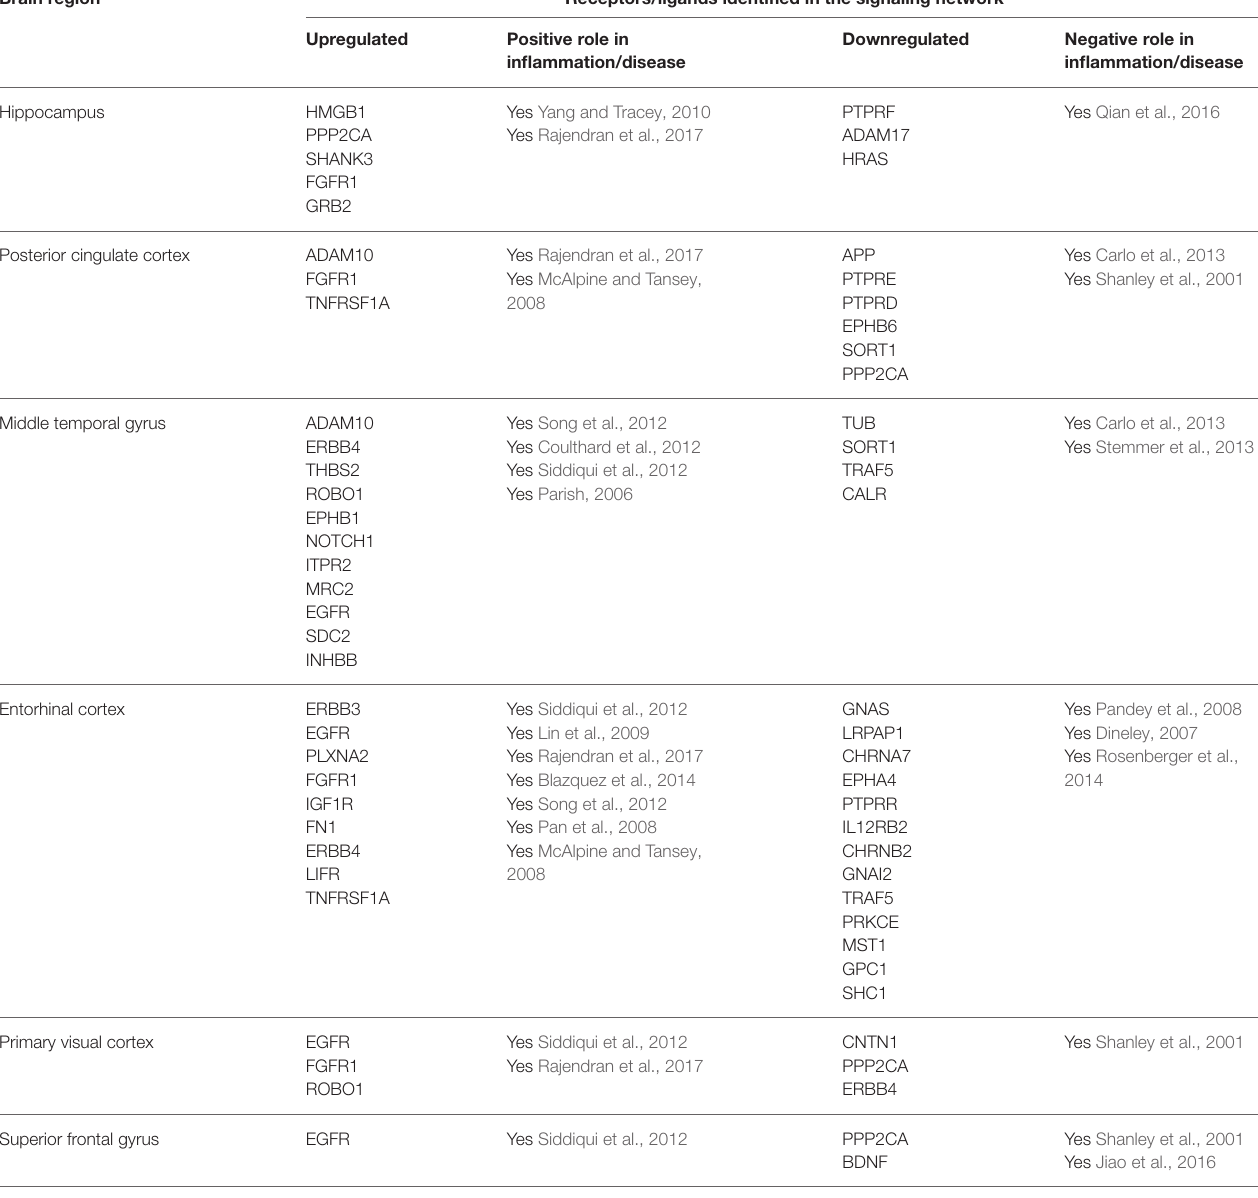
TABLE 1 | Identification of AD specific factors. Brain region Receptors/ligands identified in the signaling network Upregulated Positive role in inflammation/disease